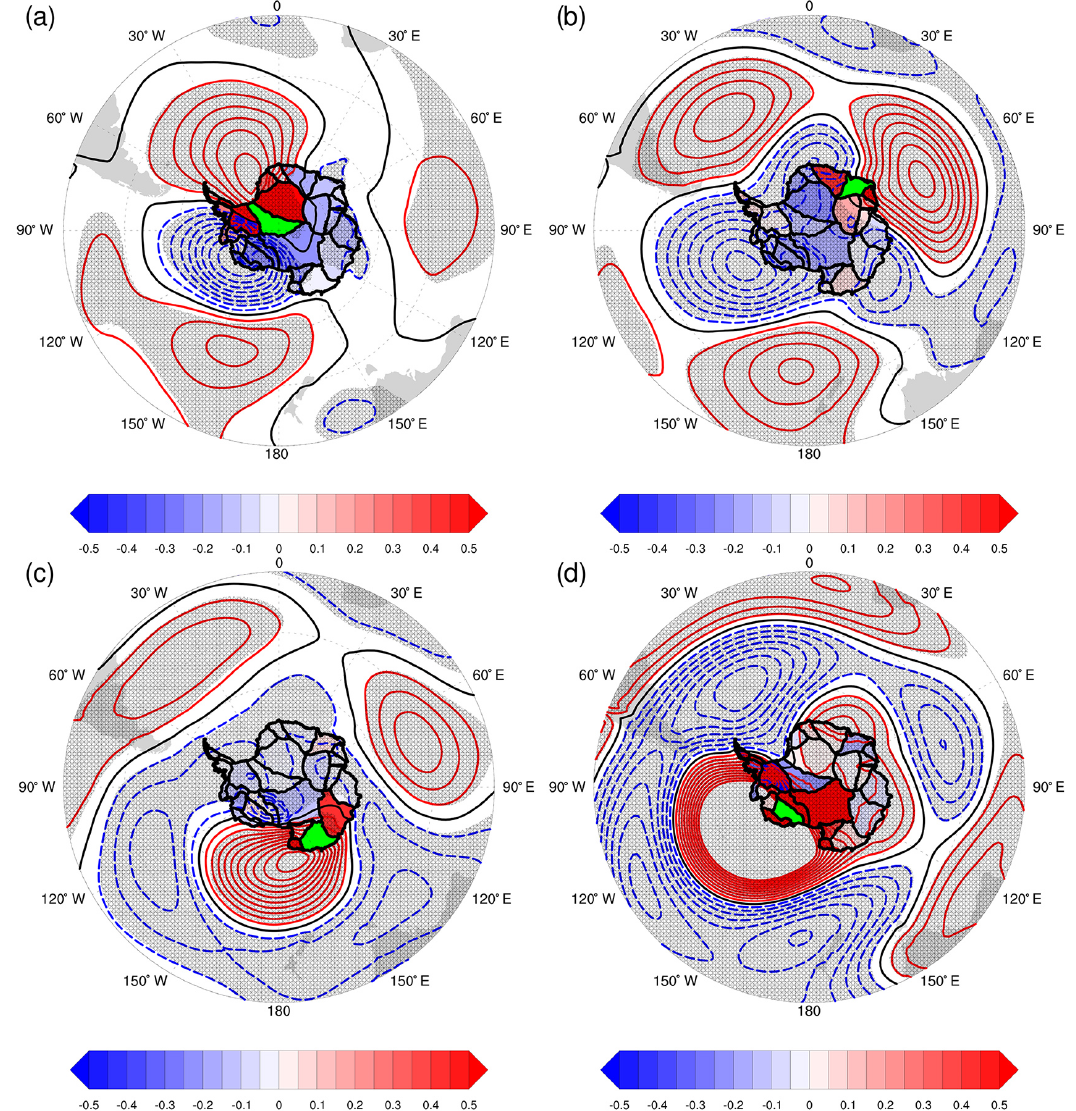
Figure 5. (a–d) Basin-resolved composite climatology Z500 differences (high minus low basin-specific integrated precipitation). Contours at 3m geopotential height difference intervals. Positive inter-composite pressure difference colored red, negative inter-composite pressure difference colored blue, to a minimum/maximum of − 30/30m. Zero contour colored black. Stippling: statistically significant inter-composite (95%) Z500 difference. Basin-specific coloring and basin outlines as in Fig.